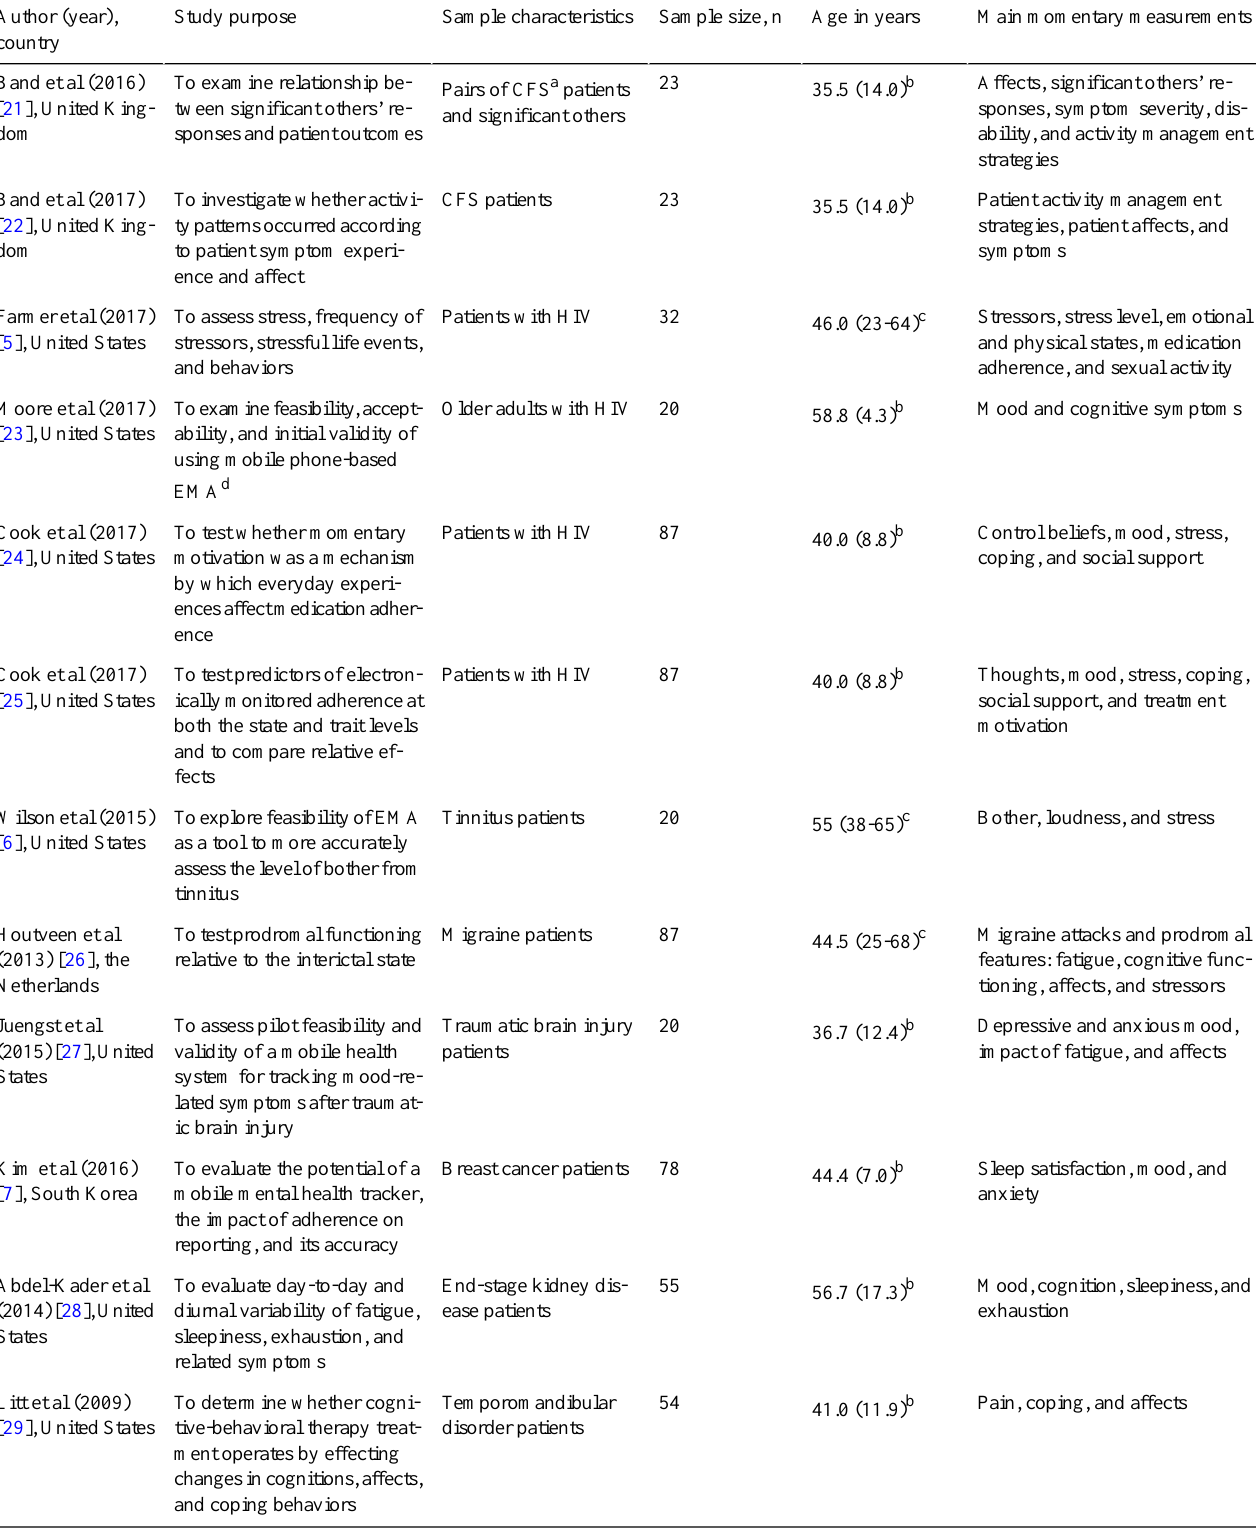
Table 1. Study details including study purpose, sample characteristics, and main momentary measurements.